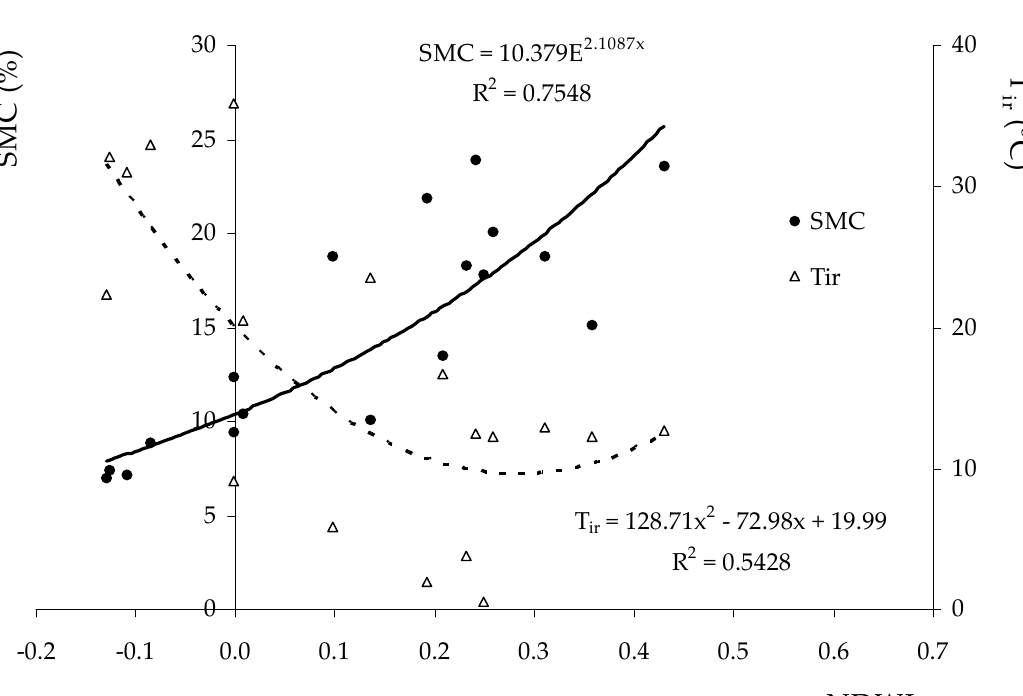
Figure 9. Relationship between normalized difference water index (NDWI), soil moisture content (SMC) and pasture surface temperature (T ir ) over sampling times (between January 2017 and June 2018). Data are average values of 12 sampling points.